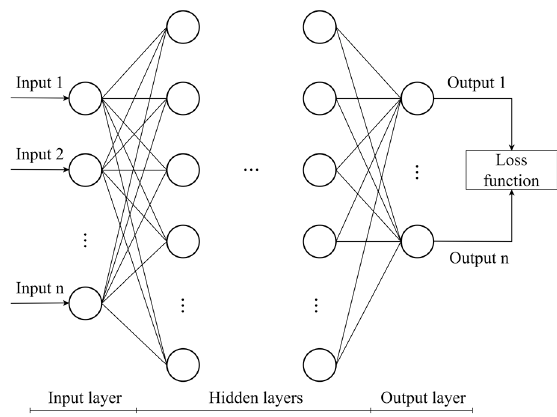
Figure 1. Typical architecture of a multilayer perceptron neural network.